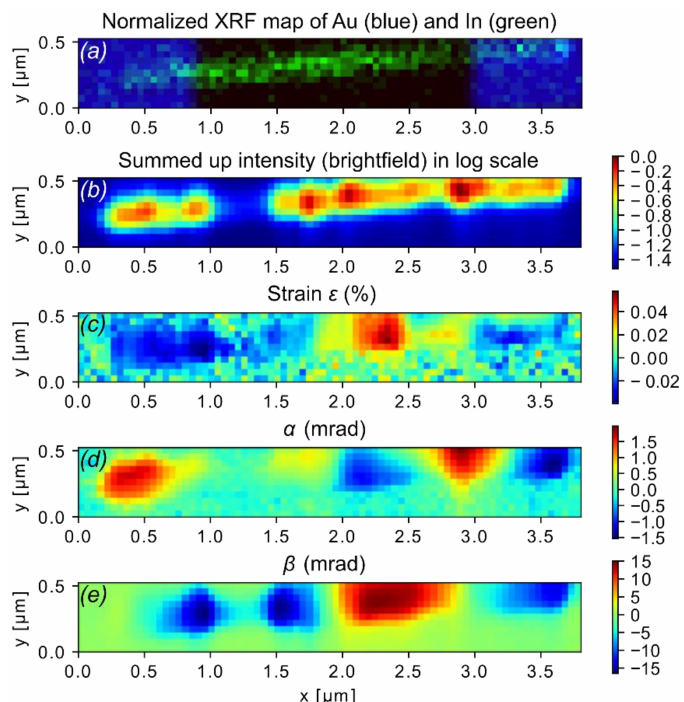
Figure 5. Scanning XRD of a single nanowire device (similar but not identical to the device in Figure 4): ( a ) XRF map, showing Au (blue) and In (green), ( b ) total intensity of the Bragg peaks ( c ) strain, in %, ( d ) lattice tilt around the optical axis, ( e ) lattice tilt around the vertical axis.